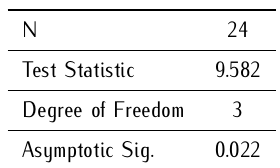
Table 4. Results of Friedman test on Enjoyment of the Visuals Variable